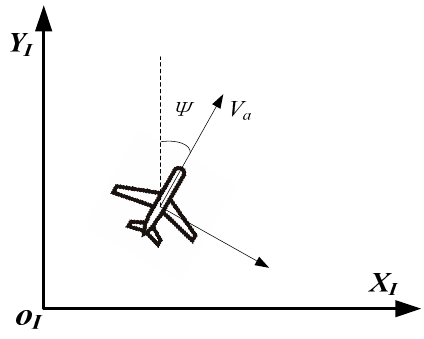
Figure 1. Schematic diagram illustrates the coordinate of the Dubins model.